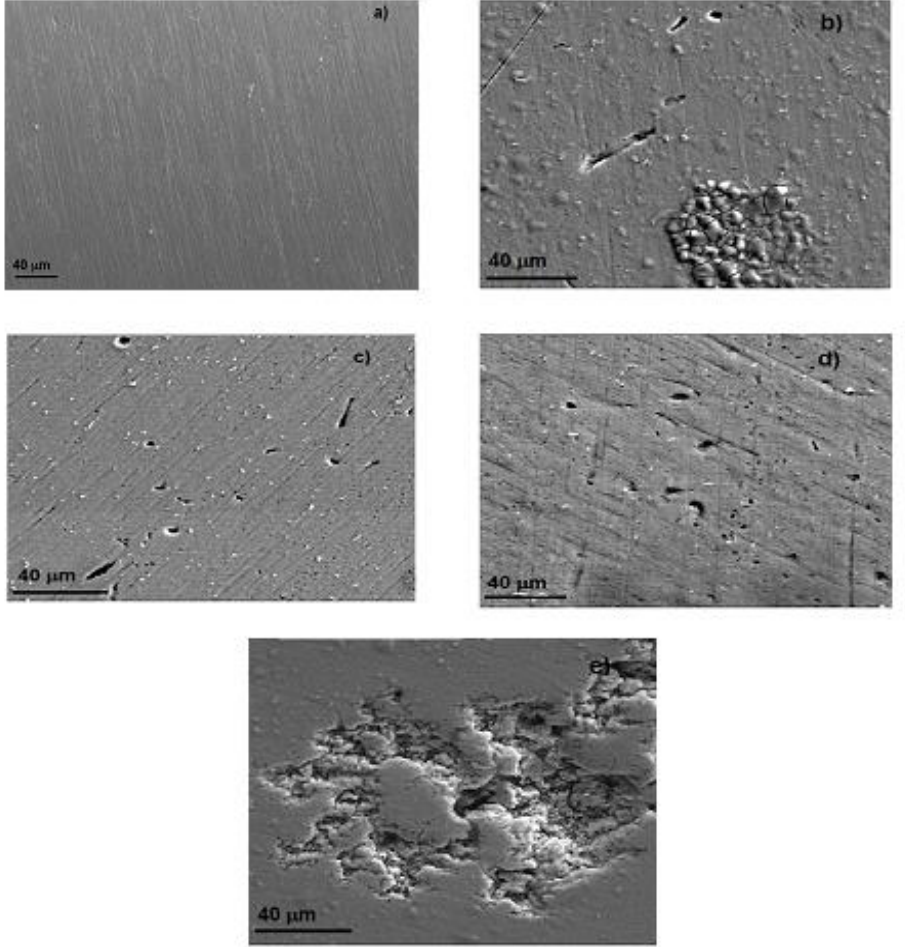
Figure 12. Micrograph of Al corroded in ( a ) gasoline and in ethanol–gasoline blends containing ethanol made from ( b ) apples, ( c ) mangos, ( d ) oranges, and ( e ) sugar cane.